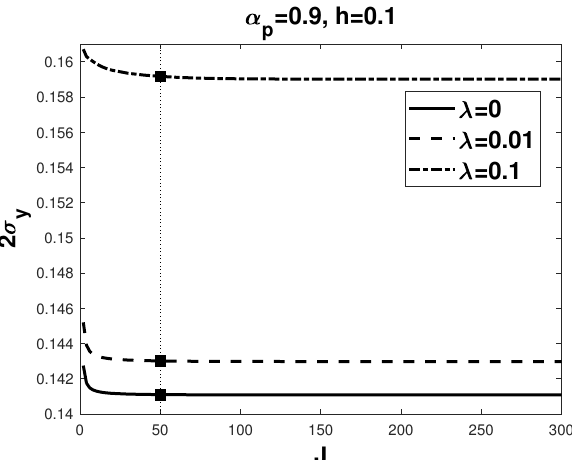
Figure 10. 2 σ y against J with limits on control signal.